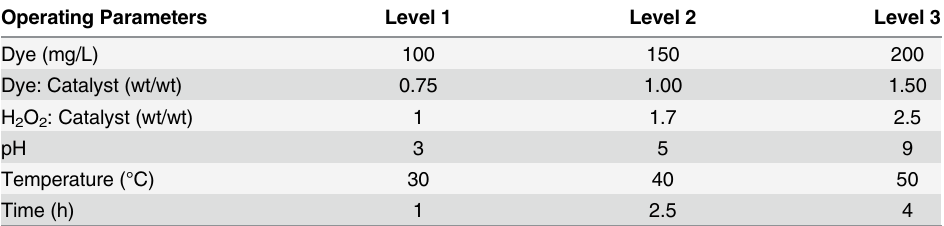
Table 3. Taguchi Design Factors and their levels.